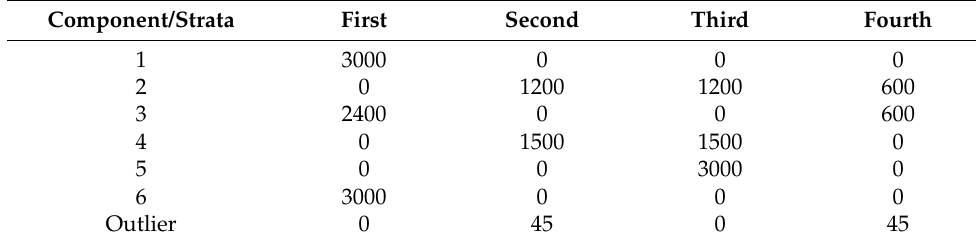
Table 2. Allocation of mixture components to